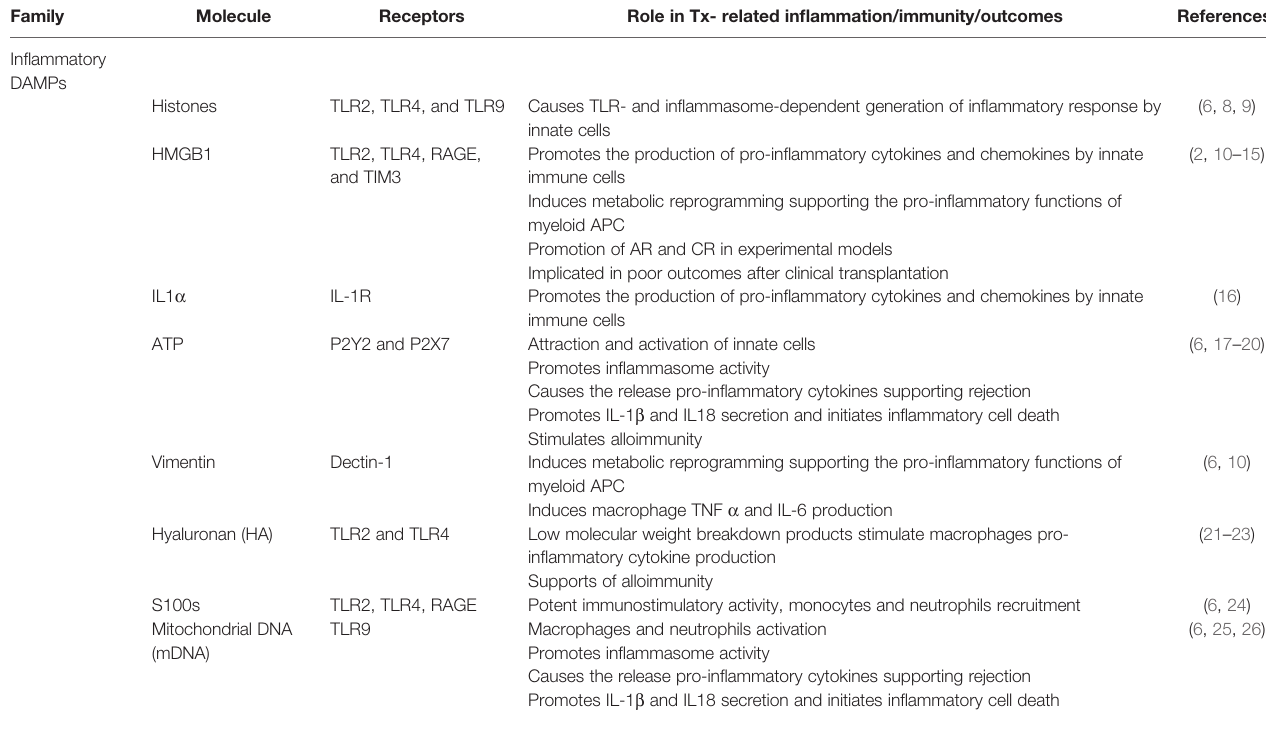
TABLE 1 | In fl ammatory DAMPs and their impact on SOTx